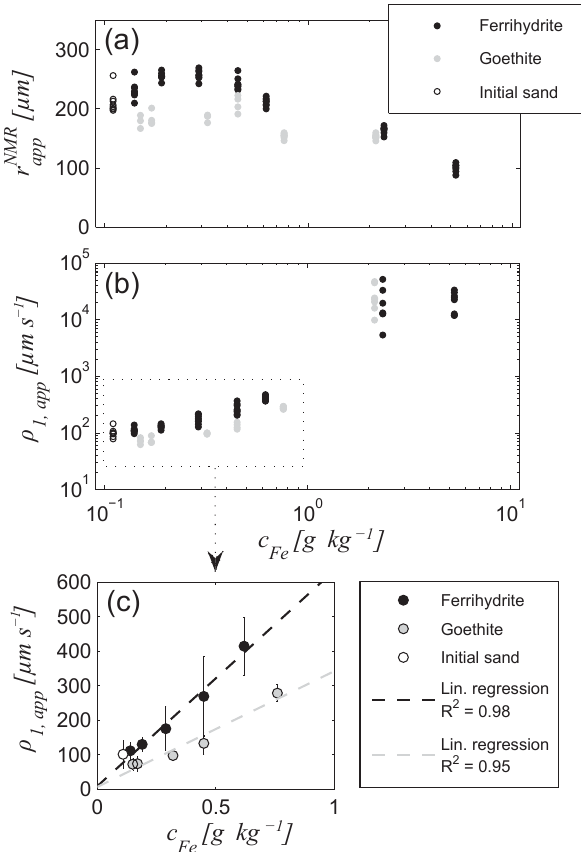
Figure 7. Results of relaxation mode inversion for the ferrihydrite and goethite data sets (Set A): (a) apparent pore radius r NMR app and (b) apparent surface relaxivity ρ 1 , app as functions of iron con- tent, (c) the mean values and 95% confidence intervals as error bars for Fe contents smaller than 1gkg − 1 and corresponding lin- ear regression lines; regression coefficient for the ferrihydrite se- ries: 646µms − 1 ppm − 1 (offset: 8.7µms − 1 ) and for goethite series: 349µms − 1 ppm − 1 (offset: 9.5µms − 1 ).